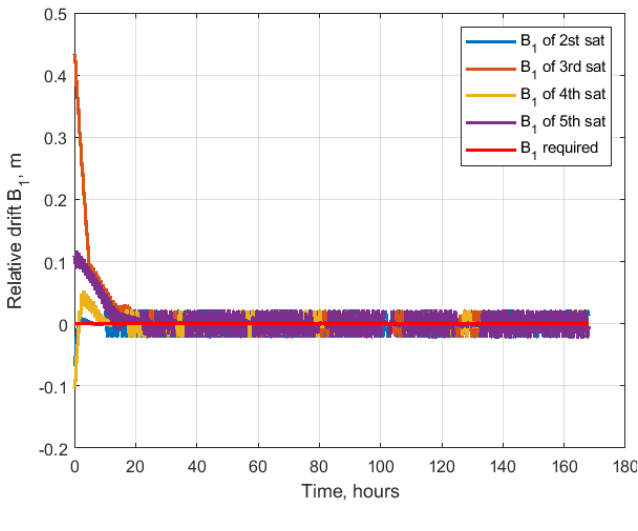
Figure 32. Relative drift.